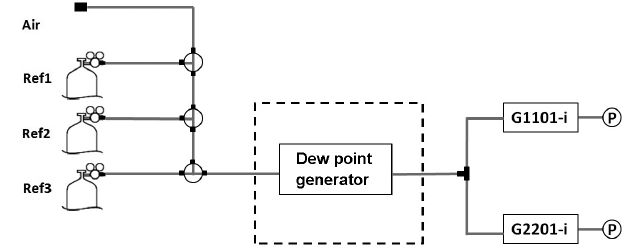
Figure 1. Schematic setup of the laboratory and ambient measure- ments of two Picarro CO 2 δ 13 C